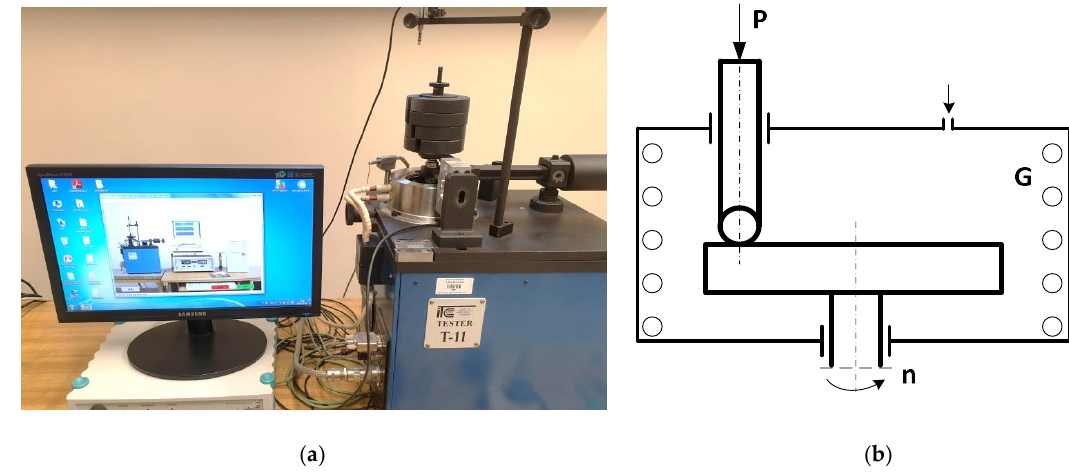
Figure 1. Photo of tribological tester T-11 ( a ) and scheme of frictional pair; P—load, G—heater, n—rotational speed ( b ).